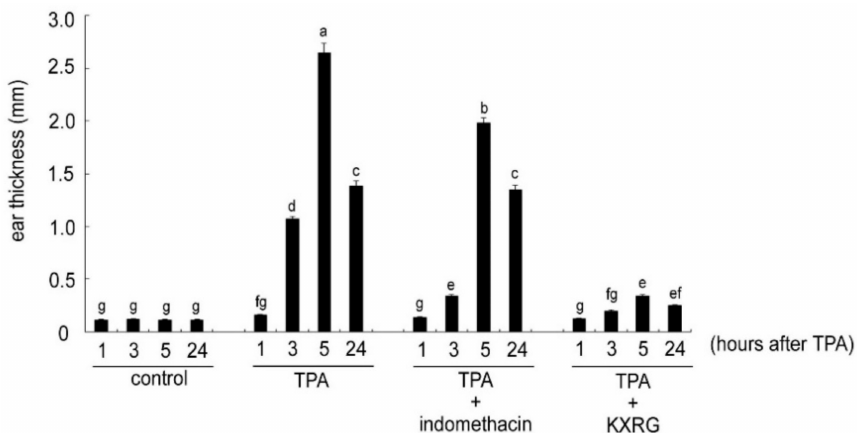
Figure 3. Effect of KXRG on the inhibition of 12-O-tetradecanoylphorbol acetate (TPA)-induced mouse ear edema in Balb/c mice. After treatment with KXRG (0.5 mg) or indomethacin (0.5 mg) for 30 min, 2 µ g of TPA were applied to both the inner and outer ear surfaces. At 1, 3, 5, and 24 h after TPA administration, the ear thickness was measured. Bars marked with different letters indicate statistically significant differences among groups at p <